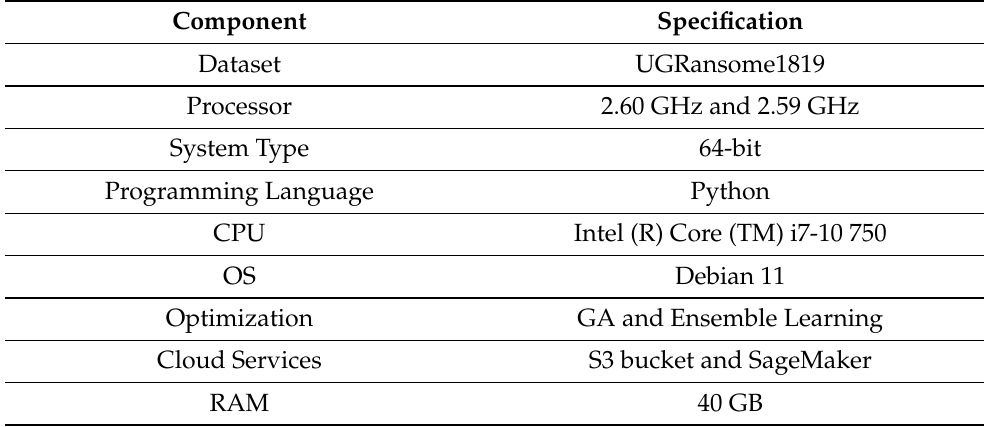
Table 2. The Computing Environment.